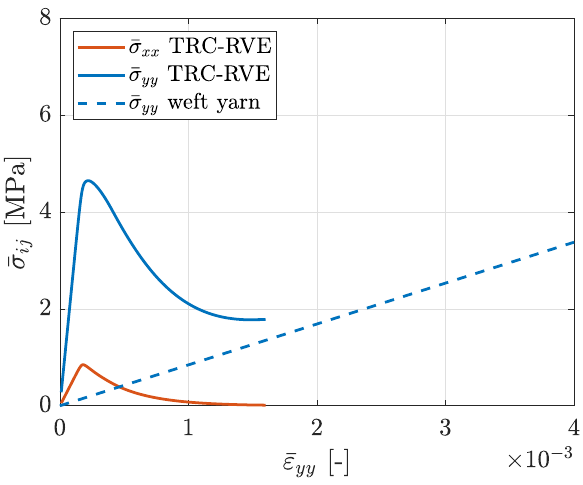
Figure 15. Effective macroscopic stress–strain relation due to tensile loading in weft yarn direction with prescribed strain ¯ (cid:101) = [ ¯ (cid:101) xx , ¯ (cid:101) yy = 0, ¯ γ xy = 0 ] .